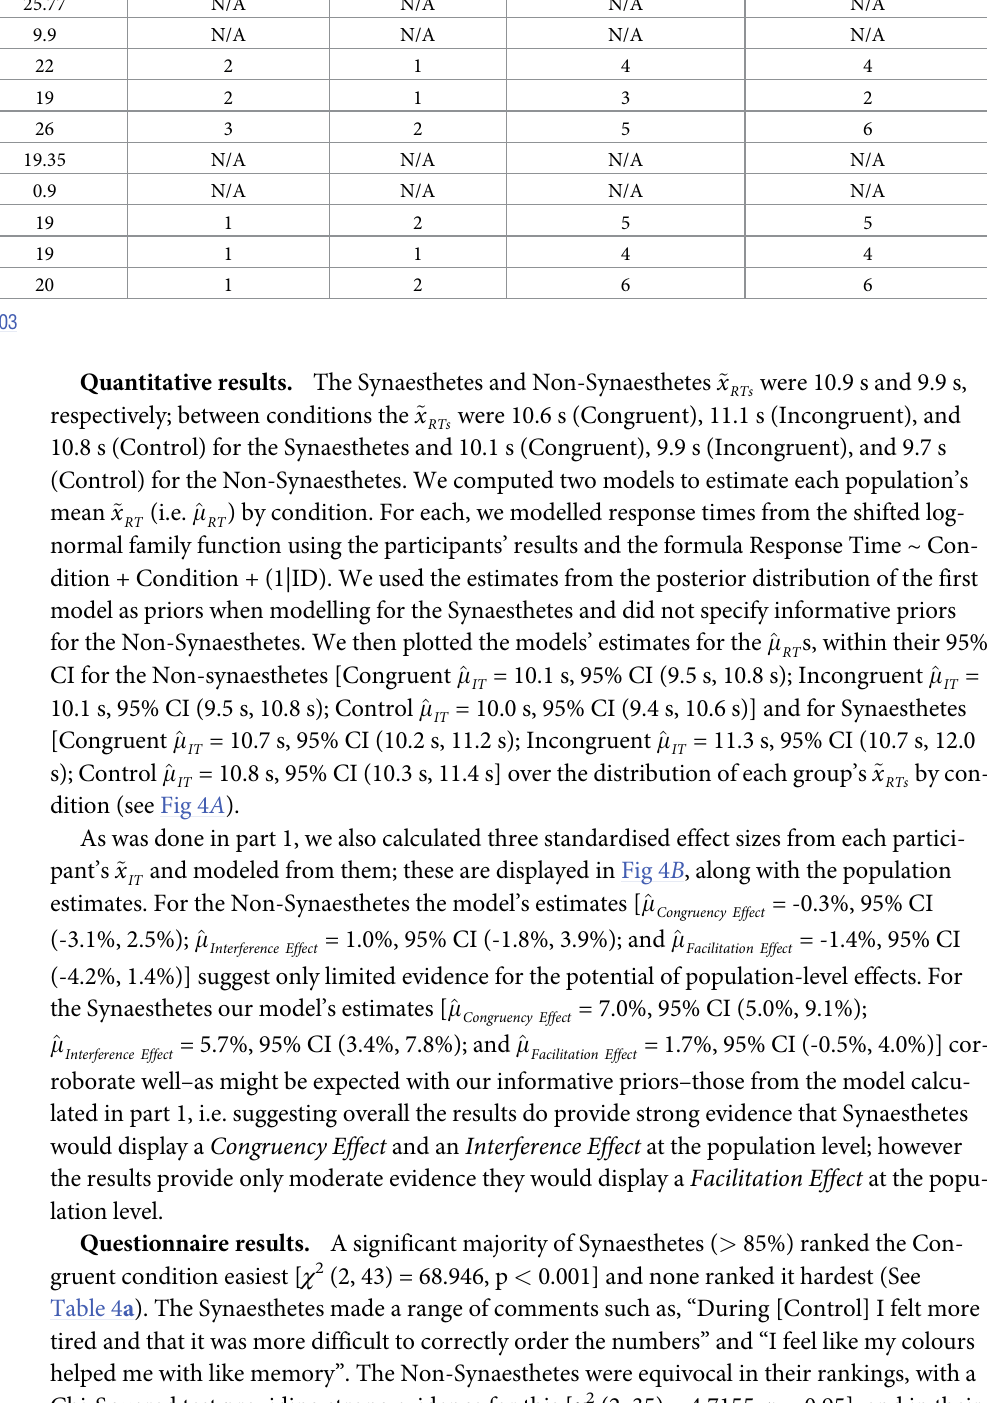
Table 3. Group experiment: part 2—synaesthetes (n = 43; 32 female and 11 male) and non-synaesthetes (n = 35; 32 female and 3 male) descriptive statistics.